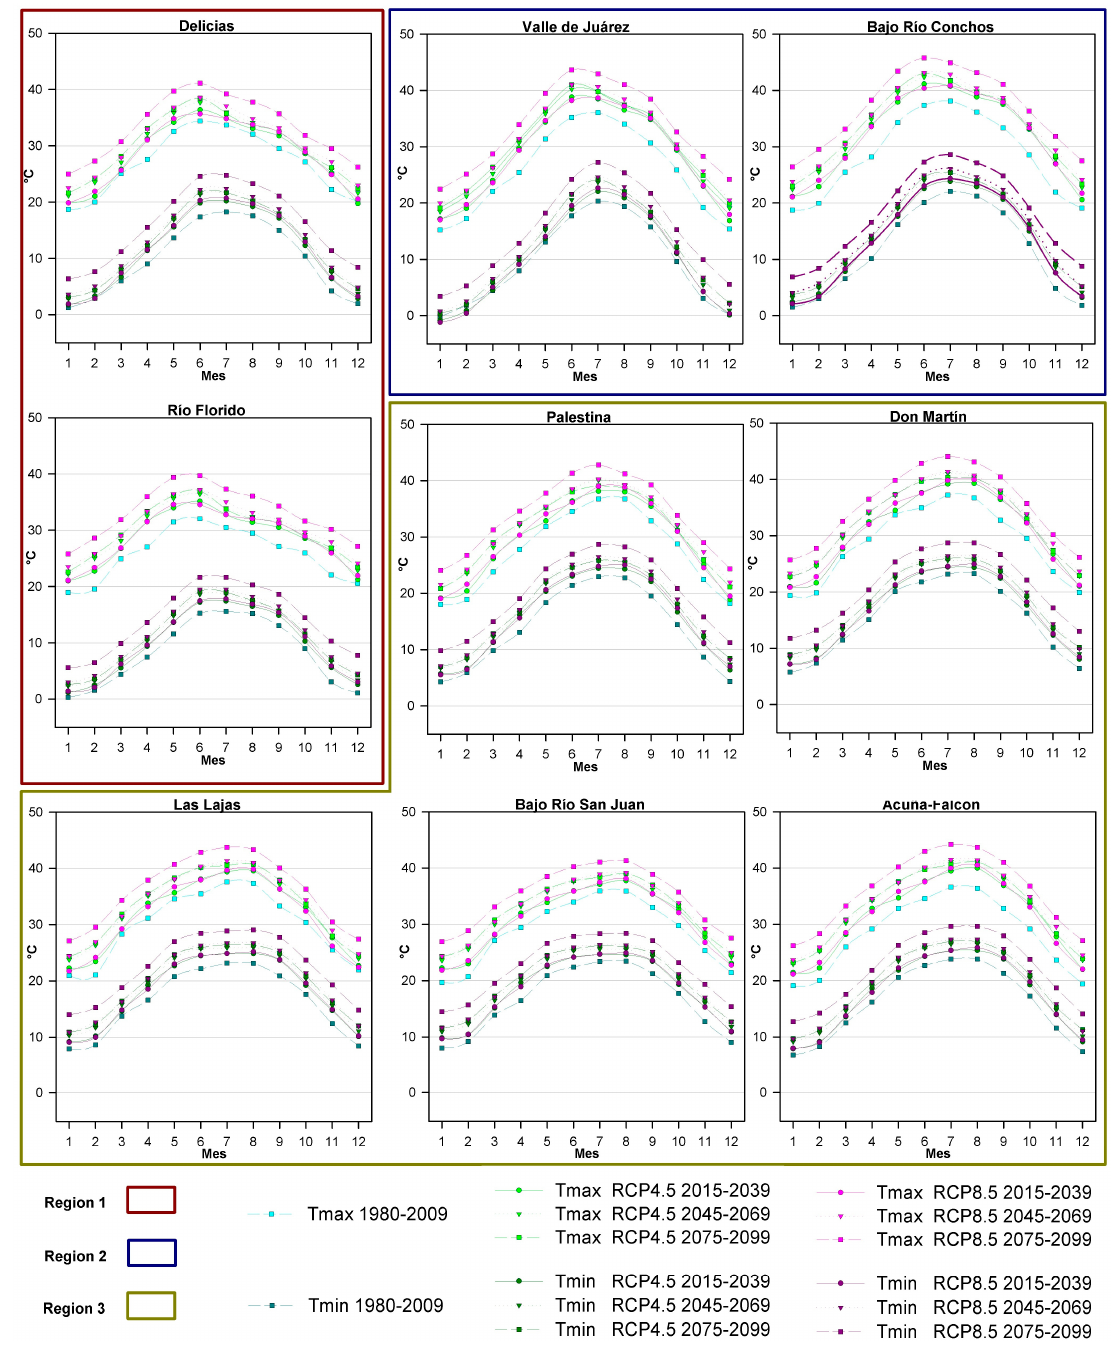
Figure 5. Monthly changes across the ID regions in average maximum temperatures ( Tmax ) and minimum temperatures ( Tmin ) for 1980–2009 in comparison to the RCP4.5 and RCP8.5 climate change scenarios projected for 2015–2039, 2045–2069, and 2075–2099 in the Rio Bravo Basin.